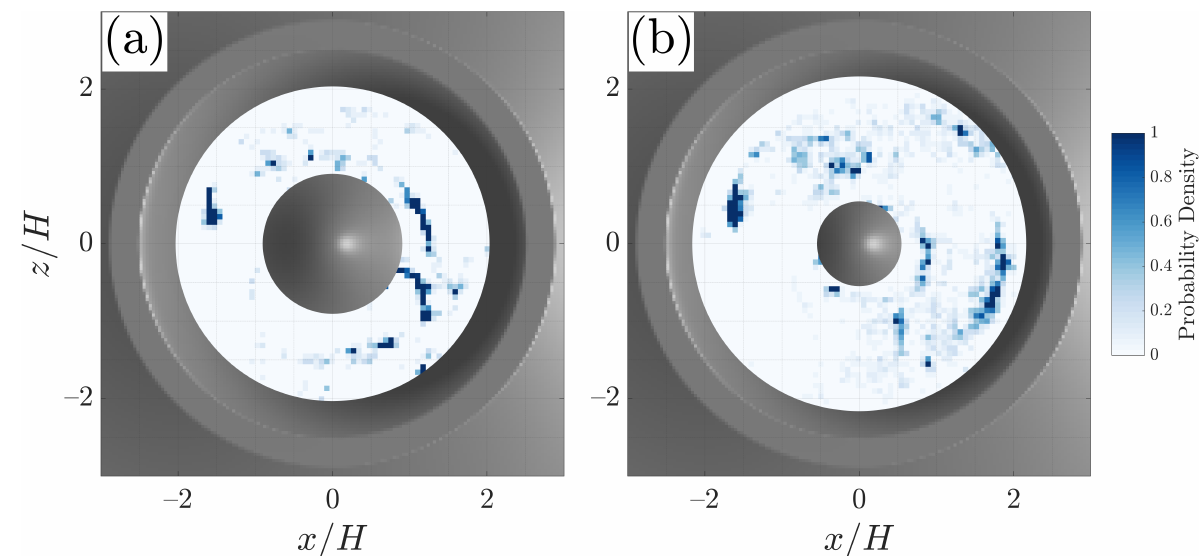
Figure 18. Probability density functions of wall-normal vortex core locations in the wall-parallel measurement planes located at ( a ) y / H = 0.3 and ( b ) y / H = 0.6. Only wall-normal vortices with positive rotation are counted. Re H = 8.9 × 10 3 .